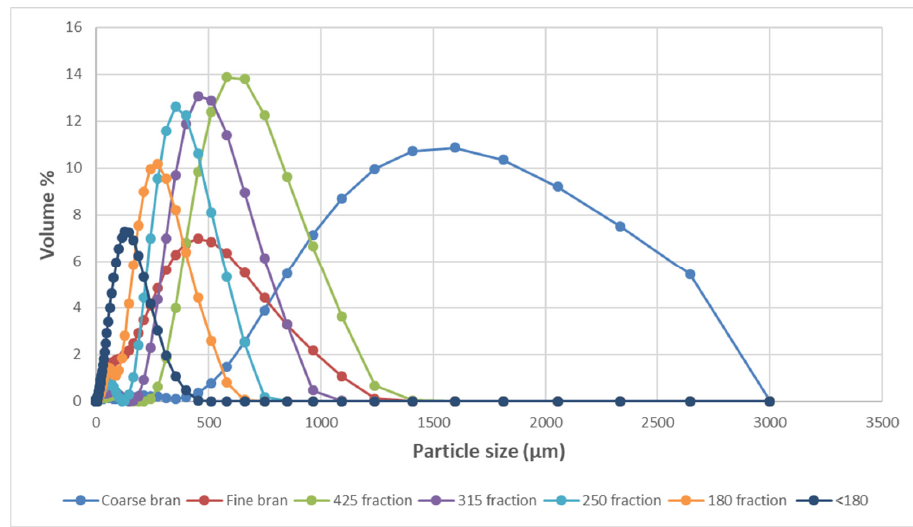
Figure 2. Particle size distribution of bran fractions coarse bran, fine bran, 425, 315, 250, 180, and <180.